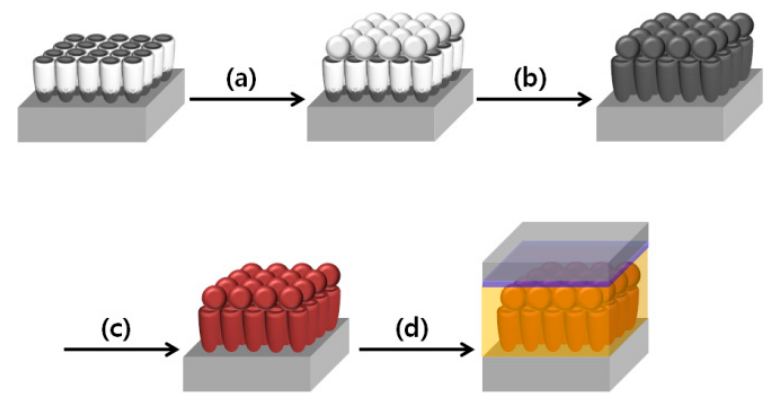
Figure 1. Overall scheme of fabrication of dye-sensitized solar cells (DSSCs) based on closed- or open-ended freestanding TiO 2 nanotube arrays decorated with large TiO 2 nanoparticles (NPs) and carbon materials. ( a ) Coating of large TiO 2 NPs; ( b ) Synthesis of carbon materials by chemical vapor deposition (CVD) method; ( c ) Dye adsorption; and ( d ) Fabrication of the DSSCs.